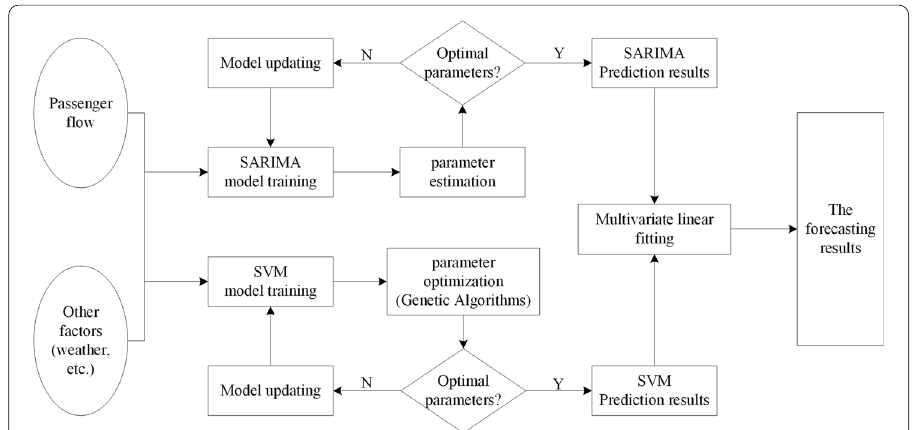
Fig. 2 Schematic diagram of SARIMA-SVM predictive